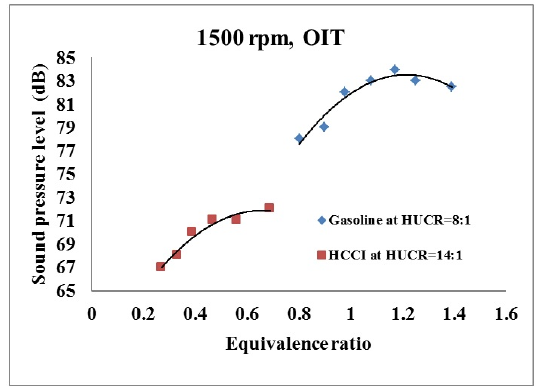
Fig. 13. CO concentrations of the two systems at HUCR for each one, for wide range of equivalence ratio.